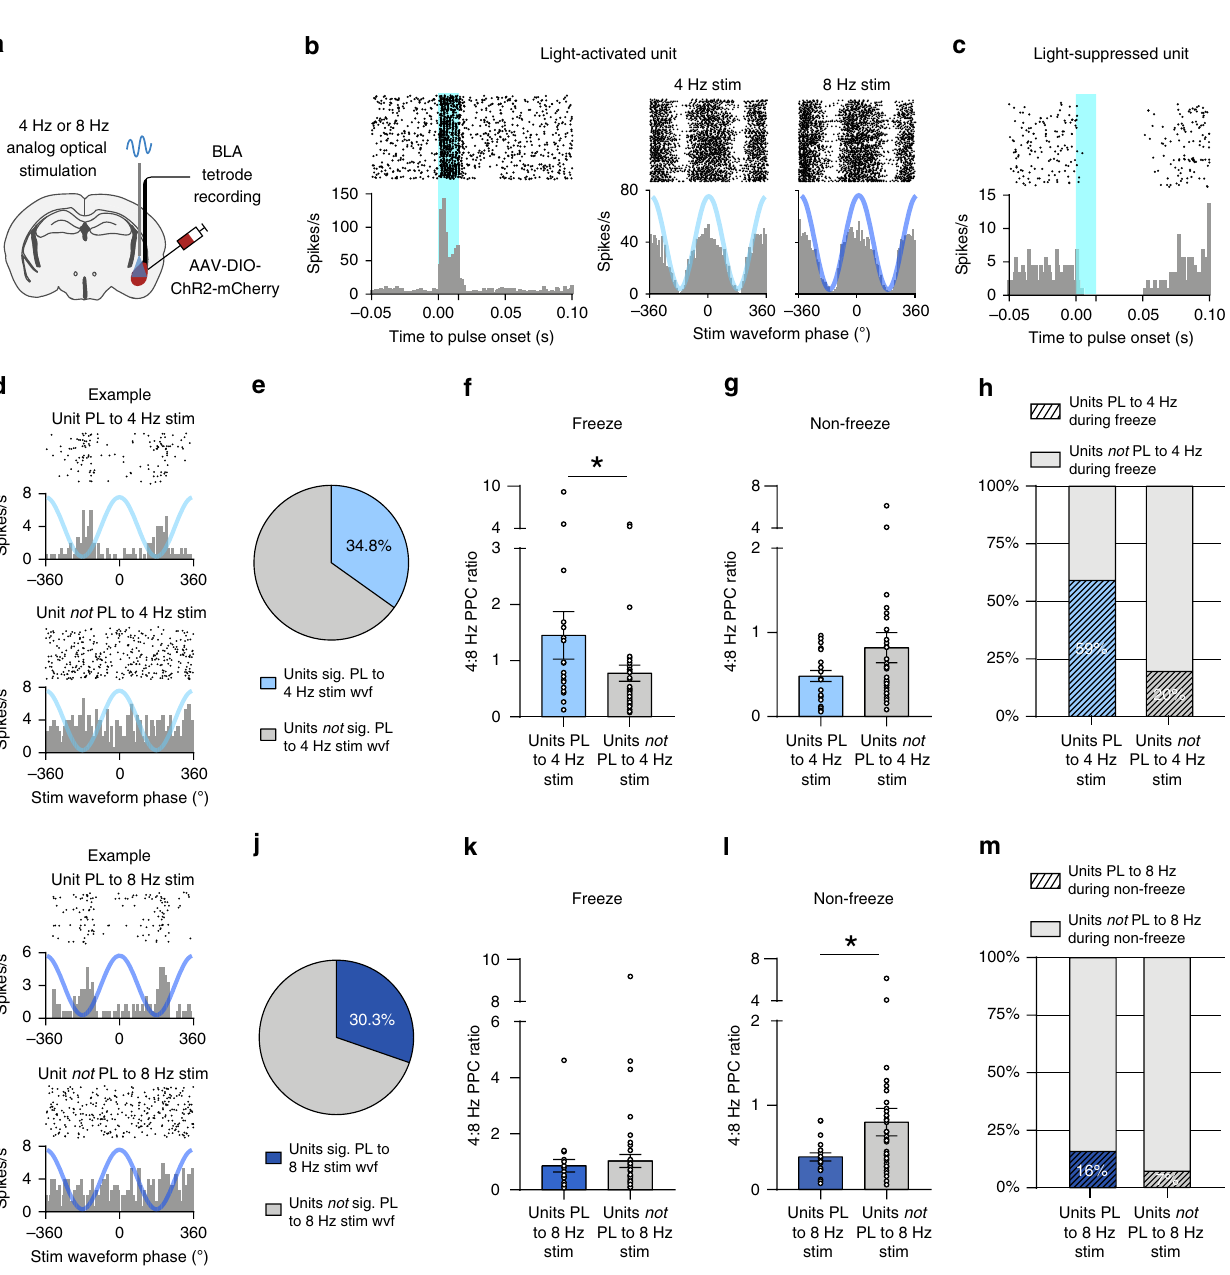
Fig. 3 4 Hz and 8 Hz stimulation recruit functionally distinct neuronal ensembles. a Experimental schematic. PV-cre mice were injected with AAV-DIO- ChR2-mCherry and implanted with optic cannulae and 32 channel tetrode drives in the BLA to extract both LFP and spiking activity in mice subjected to fear conditioning and extinction. b Raster plot (top) and spike histogram (bottom) of an example light-activated BLA single-unit, aligned to onset of 15 ms light pulses (left) or to the phases of the 4 Hz and 8 Hz sinusoidal light waveform (right). c Same as b but for a light-suppressed BLA single-unit. d Spike histograms of an example neuron that signi fi cantly phase-locks to 4 Hz stimulus waveform (top) and another unit that does not (bottom). e Percentage of units that signi fi cantly phase-lock (PL) to 4 Hz stimulus waveform during extinction memory retrieval (signi fi cance based on permutation test P < 0.05, n = 23/66 units). f Units that signi fi cantly phase-lock to 4 Hz stimulation show a higher 4:8 Hz PPC ratio during freezing than units that do not phase-lock to 4 Hz stimulation. (Mann – Whitney test, two-tailed: U = 308, P = 0.039, n = 22 and 41 units). g Same as in f but during non-freeze periods. Units that signi fi cantly phase-lock to 4 Hz stimulation and those that do not, show no difference in 4:8 Hz PPC ratio during non-freezing (Mann – Whitney test, two- tailed: U = 326, P = 0.25, n = 21 and 38 units). h Units that are recruited to endogenous freezing-associated 4 Hz oscillations are more likely to phase-lock to the 4-Hz stimulus waveform (Chi-square test: X 2 = 10.09, P = 0.0015). i Same as d but for 8 Hz stimulation. j Same as e but for 8 Hz stimulation (signi fi cance based on permutation test P < 0.05, n = 20/66 units). k , l Same as (f-g) but for 8 Hz stimulation. Units that were signi fi cantly phase-locked to 8 Hz stimulus waveform had lower 4:8 Hz PPC ratios during non-freezing periods. (Mann – Whitney test, two-tailed: Freeze (k): U = 413, P = 0.84, n = 19 and 45 units; Non-freeze (l): U = 256, P = 0.026, n = 19 and 42 units). m Comparison of percentage of units that are recruited to endogenous non- freezing-associated 8 Hz oscillations among units that signi fi cantly phase-lock to 8 Hz stimulation vs. those that do not (Chi-square test: X 2 = 1.10, P = 0.29). All error bars: mean ± SEM.